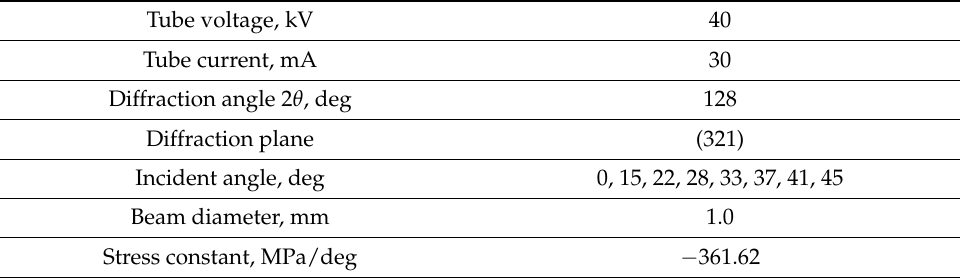
Table 2. Residual stress measurement conditions.